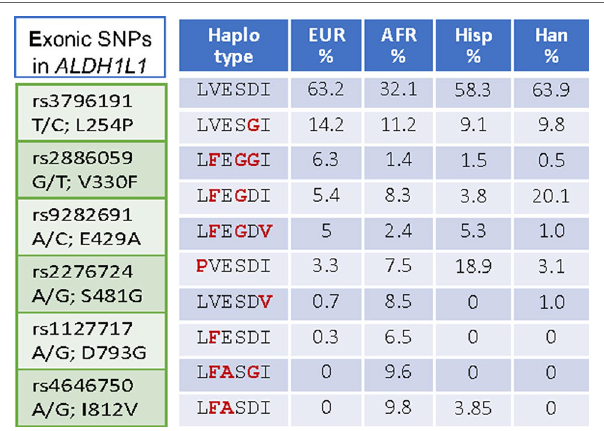
FiGURe 4 | Left panel , SNPs in the exonic region causing non-synonymous amino acid substitutions are common in ALDH1L1 . Right panel , SNP- associated haplotypes are markedly different between ethnic